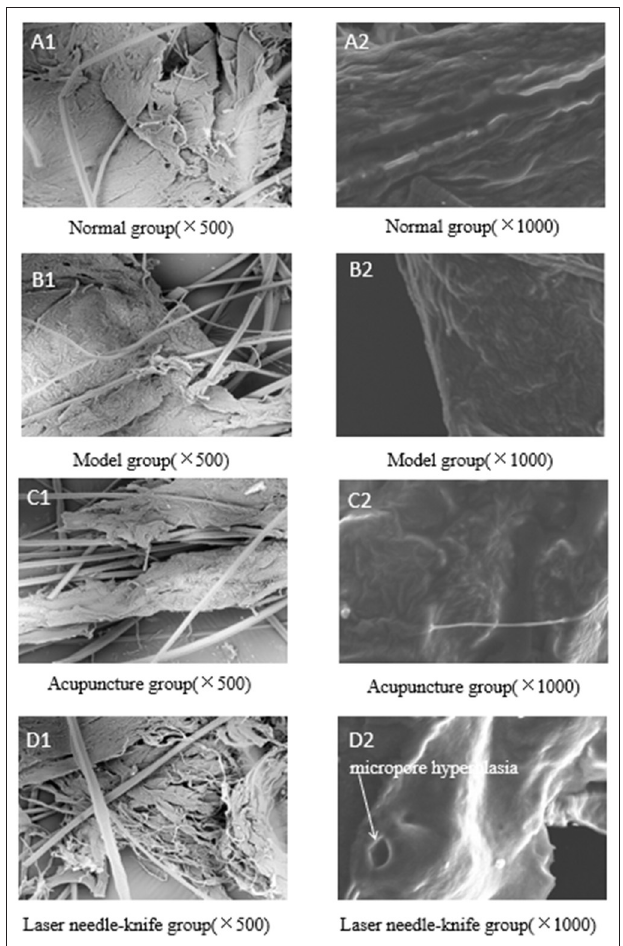
FIGURE 2 | (A–D) SEM images of different samples.